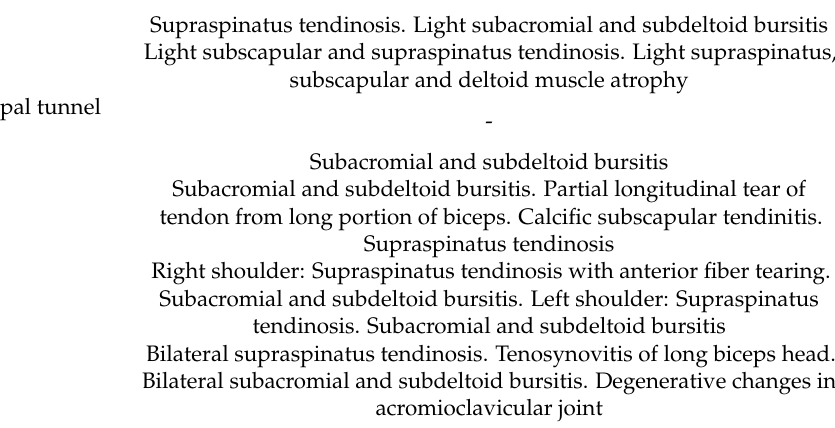
Bilateral supraspinatus tendinosis. Tenosynovitis of long biceps head. Bilateral subacromial and subdeltoid bursitis. Degenerative changes in acromioclavicular